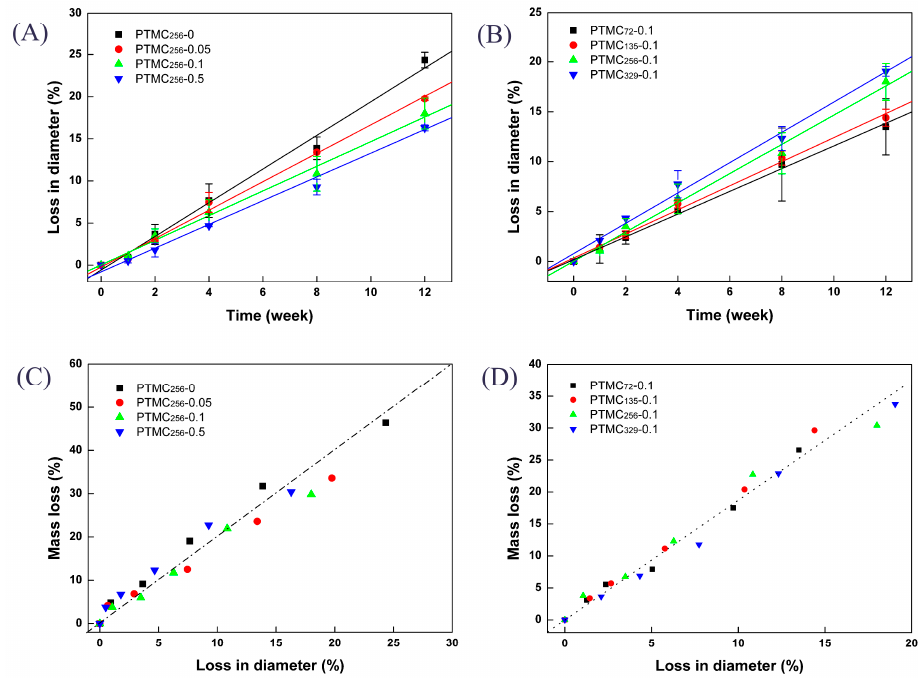
Figure 8. The loss in diameter ( A , B ) and the relationship between the mass loss and loss in diameter ( C , D ) of PTMC-Ns with different BTB amount ( A , C ) and different initial molecular weight ( B , D ) during degradation in 37 °C lipase solutions.